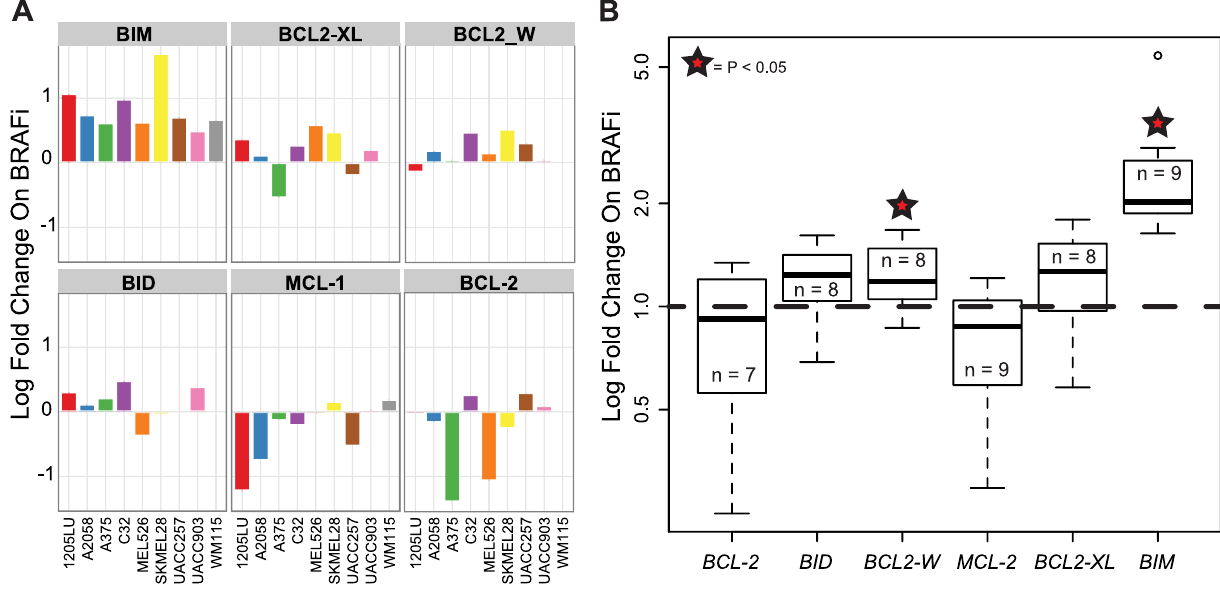
Figure 4. Expression levels of BCL2 family members in a panel of BRAF mutant cell lines undergoing BRAF inhibition. ( A ) mRNA expression levels of various BCL2 family members were quantified by real-time PCR changes and are plotted as log fold difference from vector control (DMSO). ( B ) Across our panel of cell lines, BCL2-W and BIM increased significantly from control in the context of BRAF inhibition. PLX4720 (1 m M) was used as BRAF